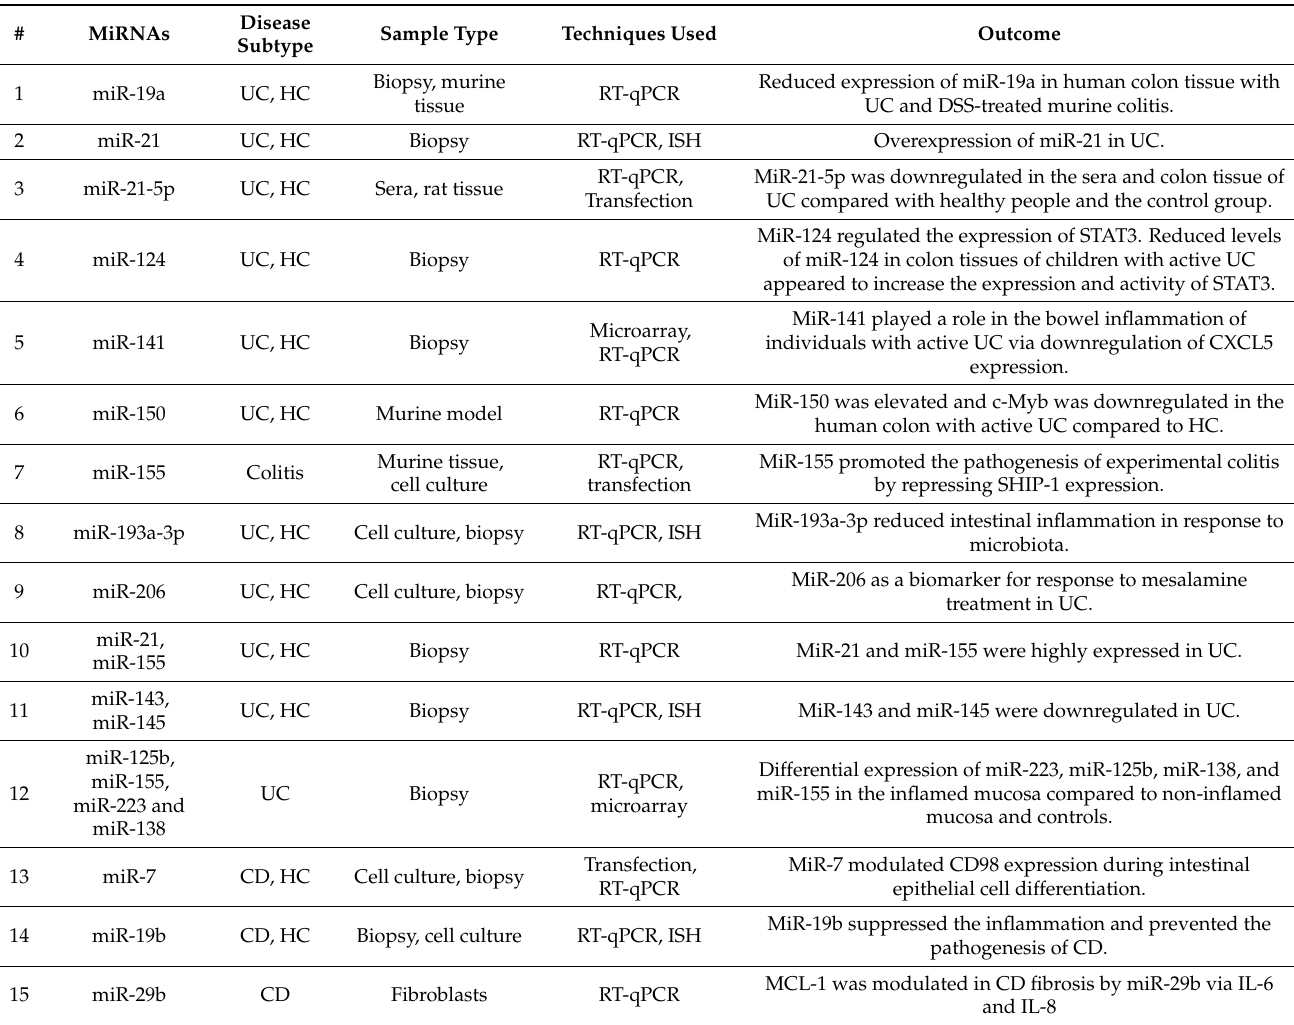
Table 2. A summary of microRNAs that are correlated with ulcerative colitis (UC#1–12) or Crohn’s disease (CD,